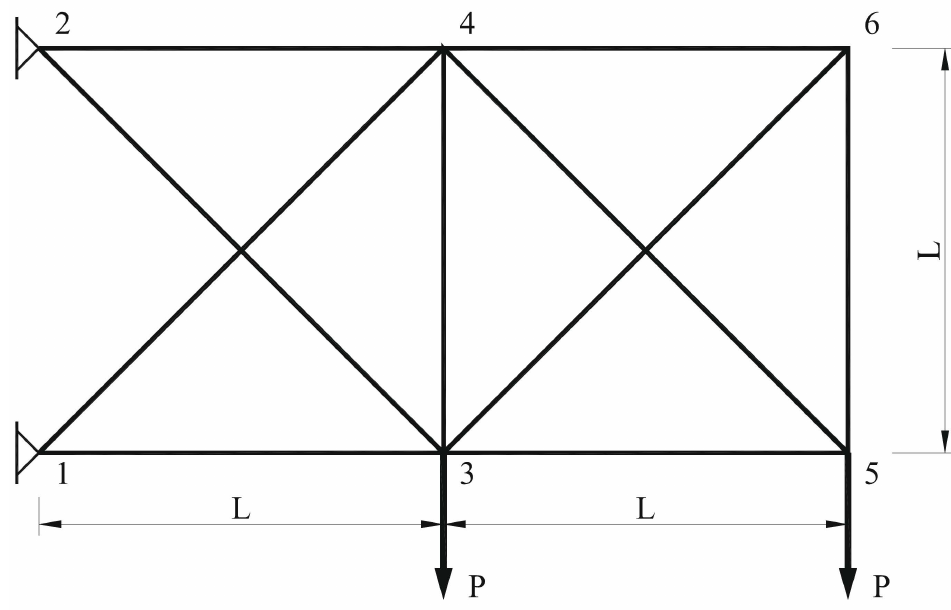
Figure 5. The ten-bar truss